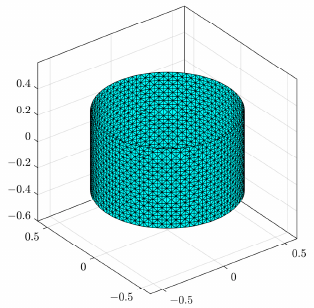
Figure 6. Cylindrical shell model under VFIFE.